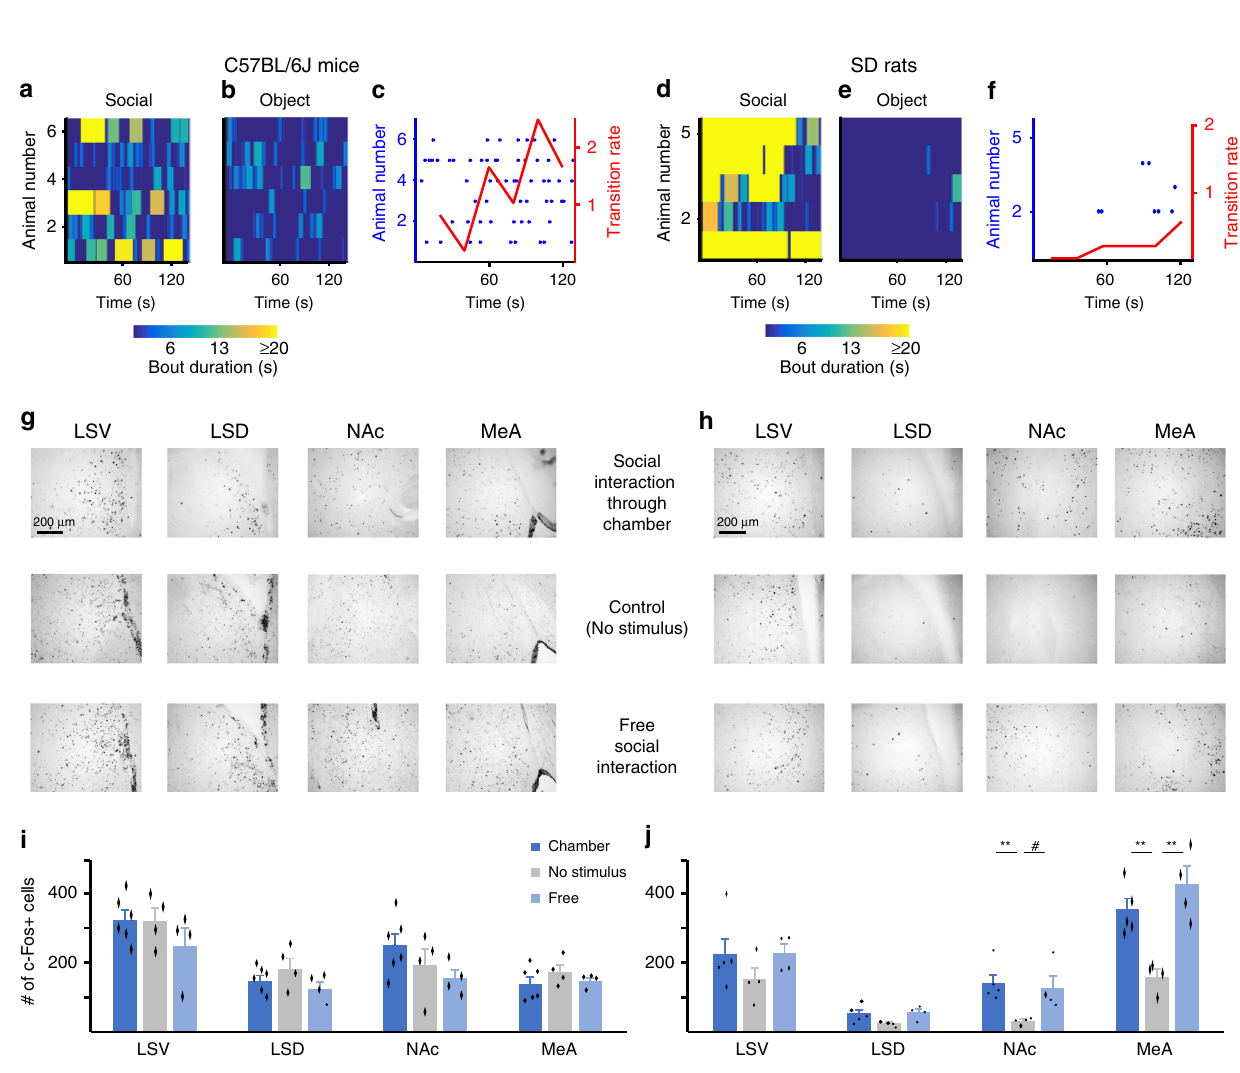
Fig. 6 C57BL/6J mice and SD rats differ in c-Fos induction by exposure to novel social stimuli. a Heatmap of investigation behavior of six C57BL/6J mice toward the social stimuli in a 2-min SP test, with each line representing a single animal. b As in a , for the object stimuli. c Analysis of transitions between stimuli made during the same experiments described in a , b , with each transition represented by a punctum and each animal by a row. Mean values (averaged over 20-s bins) are shown by the red line (right y -axis). d – f As in a – c , for fi ve SD rats. g Representative images of c-Fos immunostaining in the four brain areas denoted above, for one mouse from each of the three groups. h Same as g , for one rat from each of the three groups (the groups are denoted between g and h ). i Mean values of the three groups of mice (Control: n = 4, Chamber: n = 6, Free: n = 4), for each of the four brain regions. j Same as i , for rats (Control: n = 4, Chamber: n = 5, Free: n = 4). # p < 0.07, ** p < 0.01, post hoc two-tail t test with Bonferroni ’ s correction following the main effect. All error bars represent SEM. Source data are provided as a Source Data fi difference in reward between the stimuli, the higher the anxiety during the test, and C57BL/6J mice showing an initial low level, level of the subject, due to the dif fi culty of choosing between the which gradually increased. We used an evolutionary multi- two competing stimuli, which creates a motivational con fl ict 27,28 . objective optimization algorithm to fi t the model parameters In this model, the only difference between C57BL/6J mice and SD using the experimental results of the SP test in C57BL/6J mice rats was the dynamics of social reward, with SD rats showing an (see Table 2). Running the model with these parameters (Fig. 8c) initial high level of social reward, which gradually decreased on a virtual sample of 60 C57BL/6J mice resulted in dynamics of